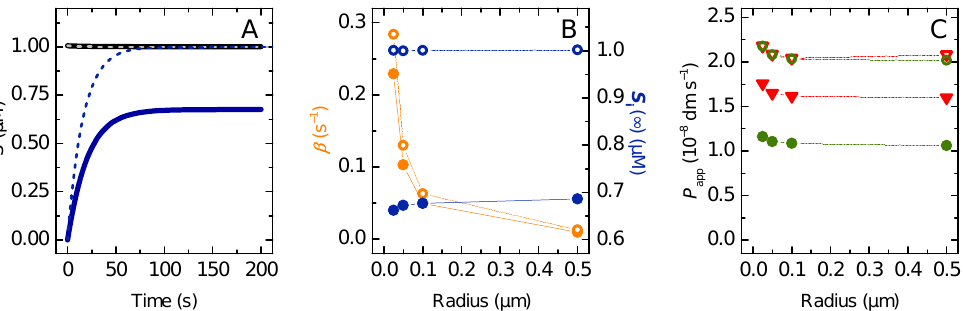
Figure 6. ( A ) Evolution of the local concentration of the total solute in the outer ( — , (cid:5) (cid:5) (cid:5) ) and inner ( — , (cid:5) (cid:5) (cid:5) ) aqueous compartments. The concentration of the corresponding species in the membrane is the same because K P = 1. ( B ) Variation of the equilibration characteristic constant ( • , concentration of solute in the inner compartments at equilibrium ( • , outer radius. ( C ) Apparent permeability coefficient ( P app • , vesicle’s outer radius. The dashed lines and hollow symbols are the results for the permeation of a non-ionisable solute, and the solid lines and filled symbols are for the permeation of the protonated form of a weak acid with the same membrane affinity and flip-flop rate constant as the non-ionisable solute and p K a = 7. The lines in plots B and C are guides for the